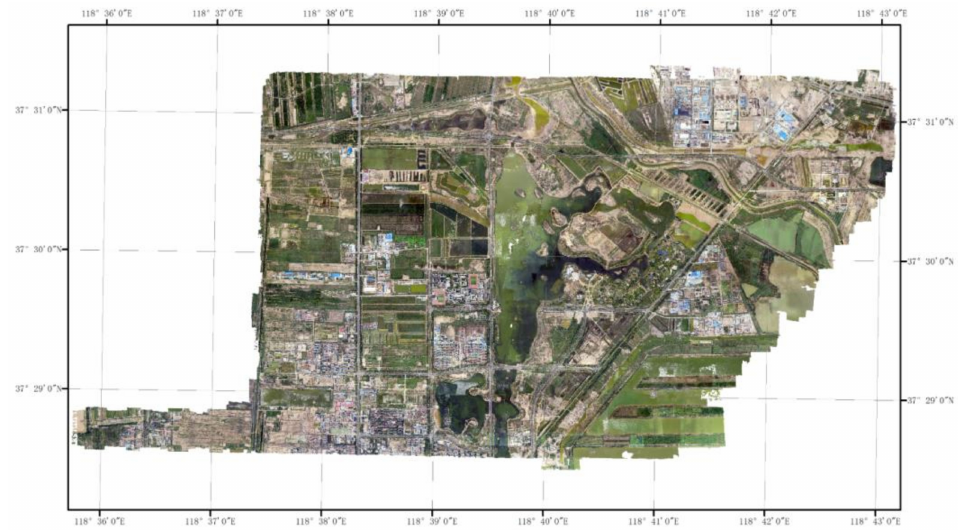
Figure 7. Experimental area.